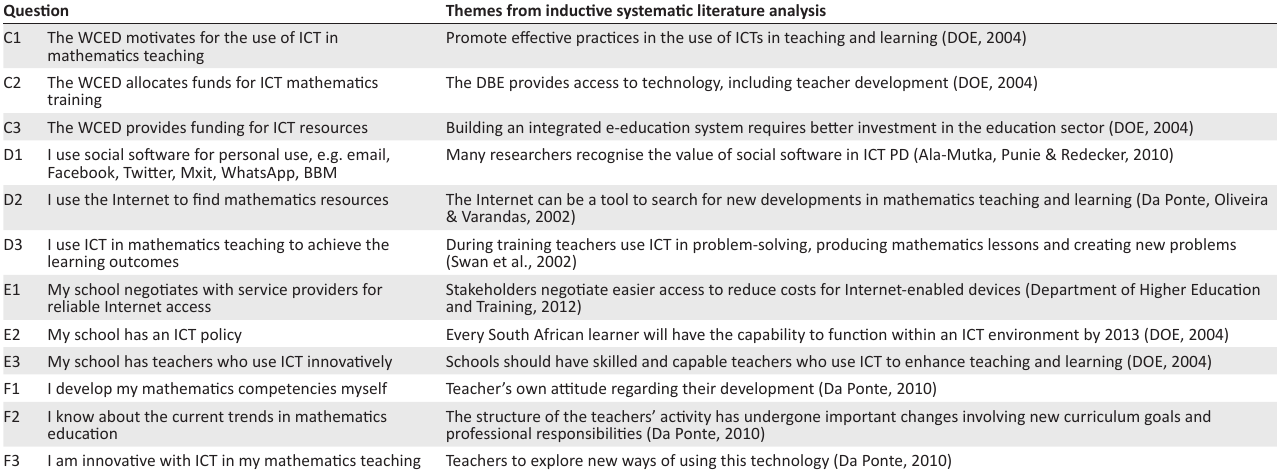
TABLE 5: Description of compilation of questions for Parts